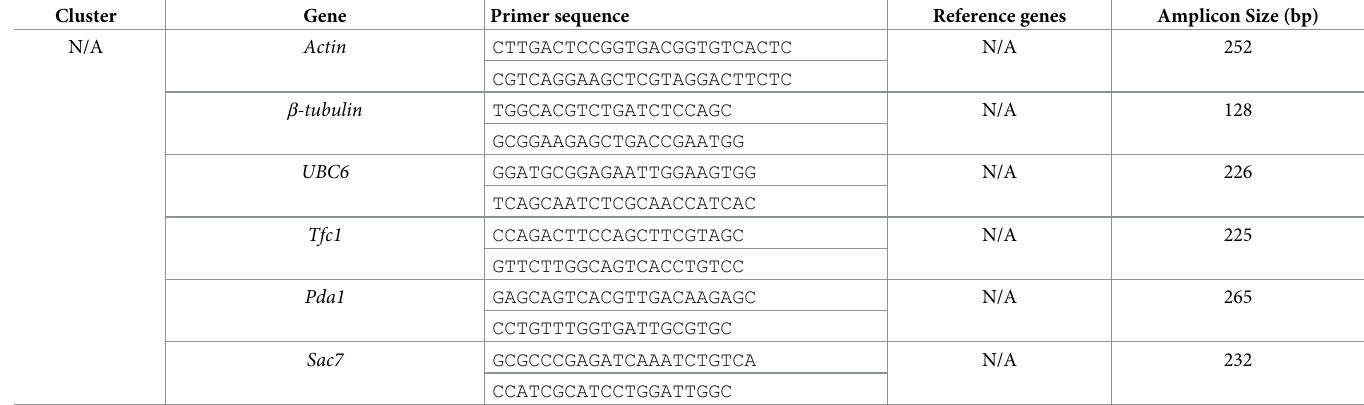
a primers used for assaying PKS8-2 expression in silencing transformants b primers used for assaying PKS10-2 expression in silencing transformants